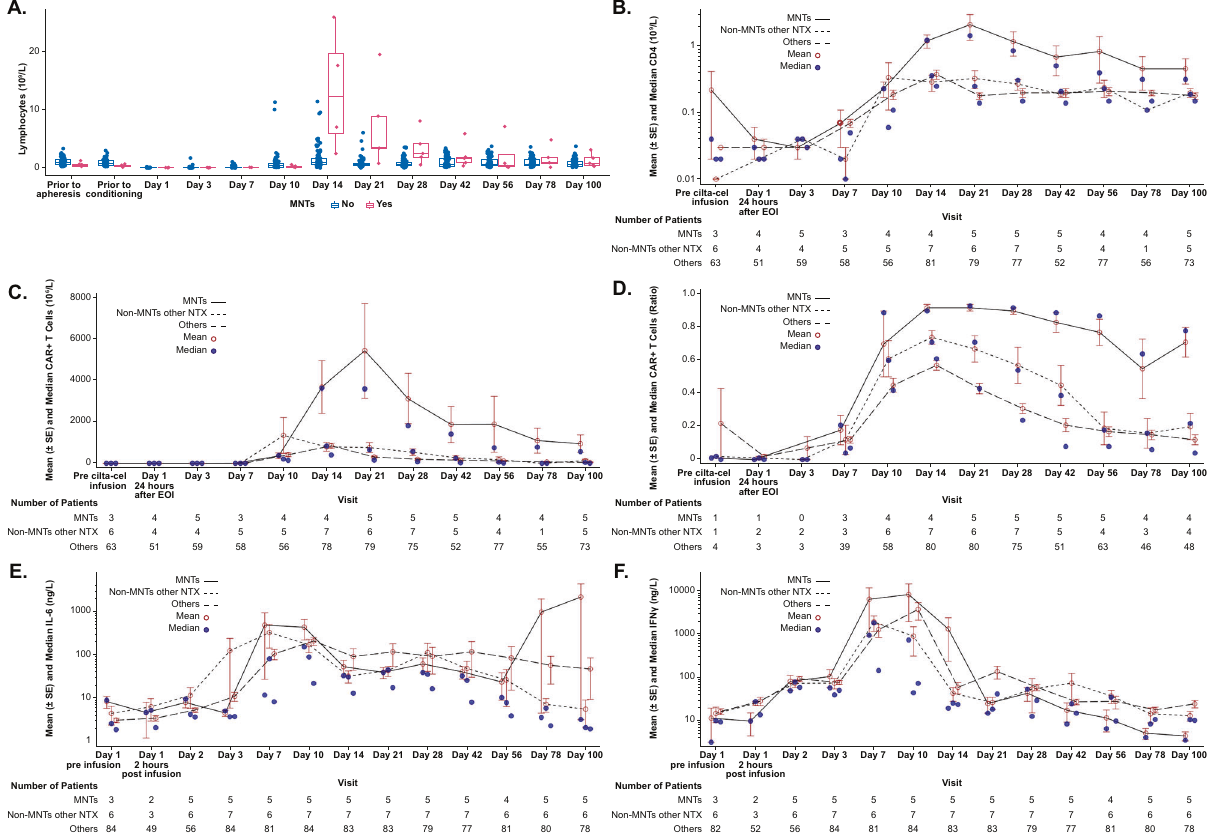
Fig. 2 Analysis of lymphocytes, T cells, and cytokines over time following cilta-cel infusion in patients with and without MNTs in CARTITUDE-1. Values are shown for A lymphocyte counts; B absolute CD4 + T-cell counts; C absolute CAR + T cells; D frequency of CAR + T cells; E IL-6; and F IFN- γ . CAR chimeric antigen receptor, EOI end of infusion, IFN interferon , IL interleukin, MNT(s) movement and neurocognitive treatment-emergent adverse event(s), NTX neurotoxicity, SE standard error.